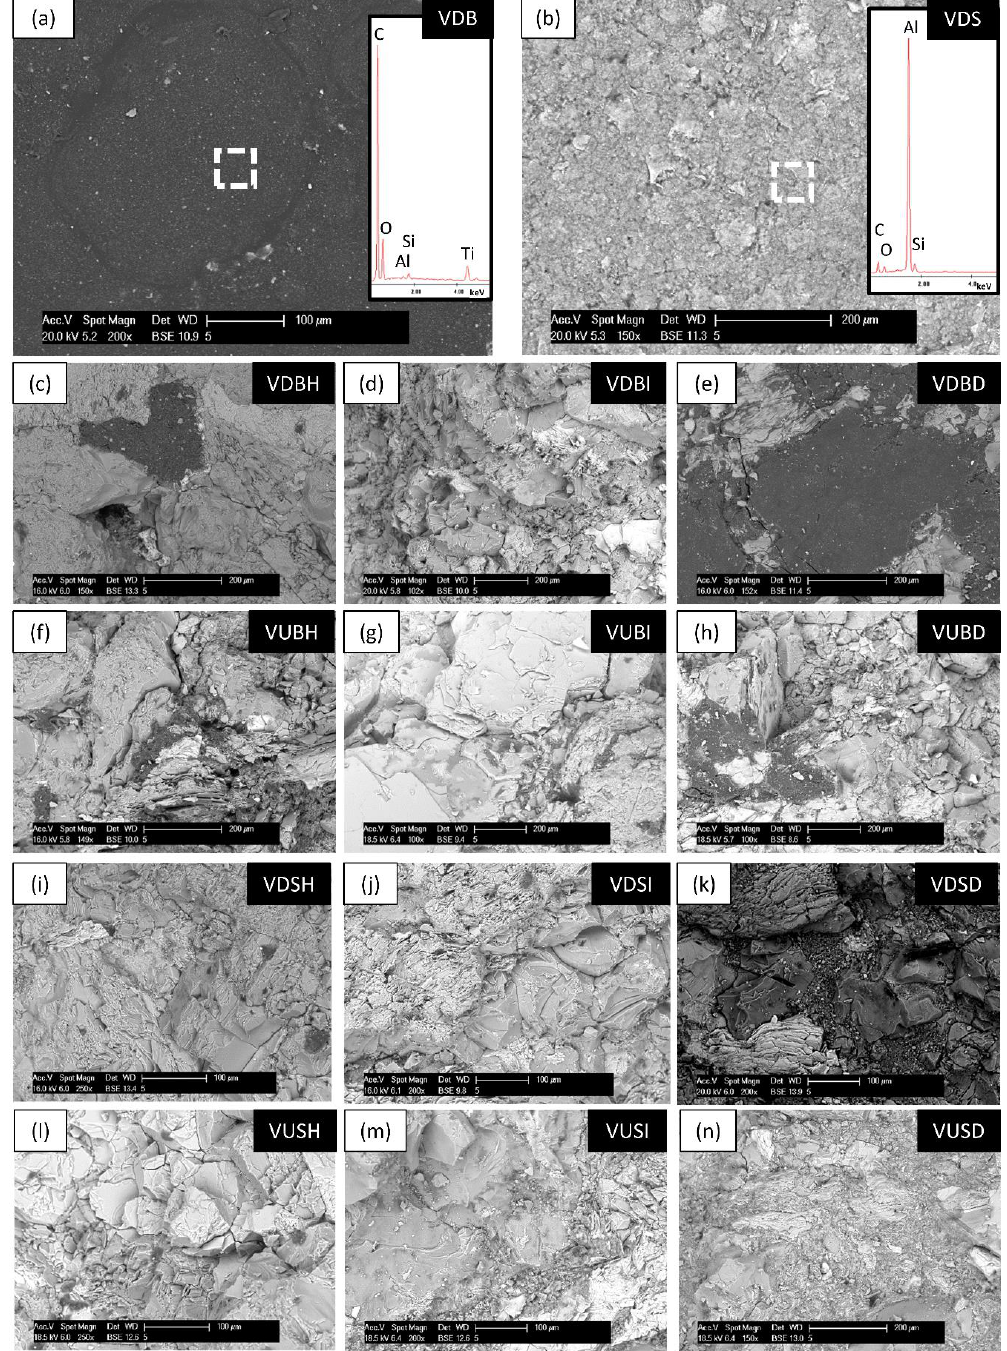
Figure 4. SEM micrographs of the granite surfaces painted with blue and silver graffiti paints ( a , b ), and granite surfaces cleaned of blue and silver graffiti paints with Hydrogommage, IBIX, and dry-ice blasting. See Table 1 for samples’ nomenclature.